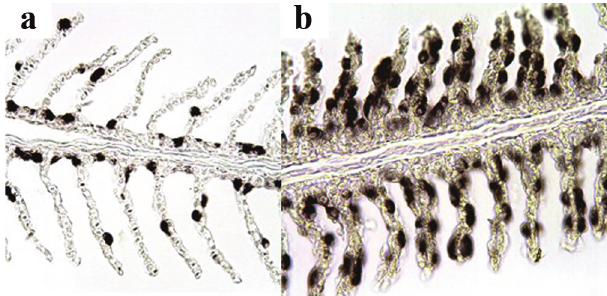
Fig. 4. Immunohistochemistry location of the Na+/K+- ATPase enzyme in the chloride cells (CC) of P . lineatus exposed to only to water ( a ) or WSFG ( b ) for 24h. Original magnification: 400